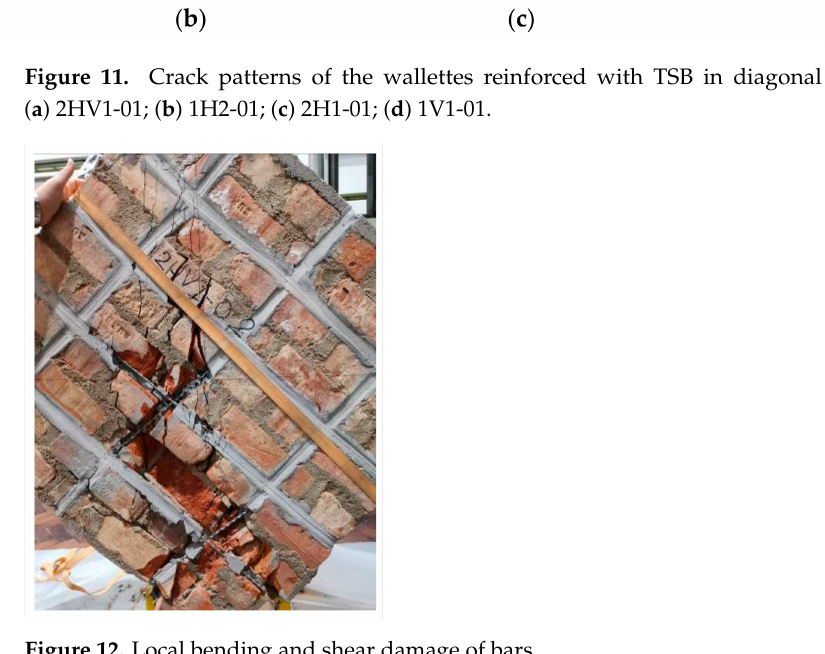
Figure 12. Local bending and shear damage of bars.